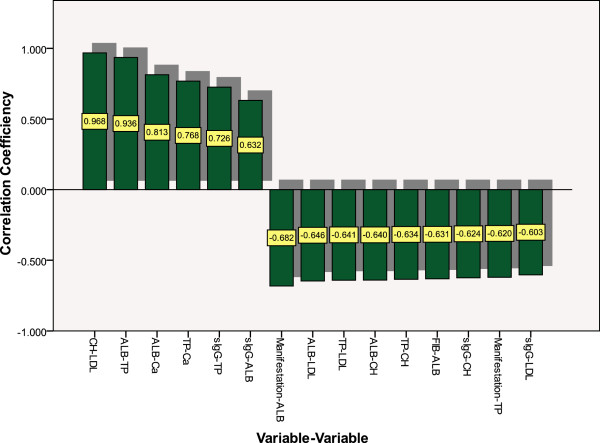
Correlation coefficients between two variables of pre-selected variables.